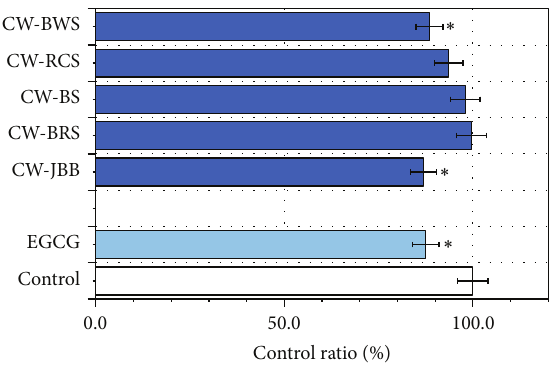
∗∗∗ Figure 7: Changes in the Thioflavin T fluorescence of BSA+D- Figure 8: Changes in the Thioflavin T fluorescence of LAB+D- ribose treated with plant sprouts’ aqueous extracts (PSAE). BSA ribose treated with plant sprouts’ aqueous extracts (PSAE). LAB (final concentration 10mg/mL) in the presence of D-ribose (final (final concentration 10mg/mL) in the presence of D-ribose (final concentration 1M) was kept at 37 ∘ C in Tris-HCl buffer (pH 7.4). concentration 1M) was kept at 37 ∘ C in Tris-HCl buffer (pH 7.4). Thioflavin T (final concentration 30 𝜇 M) was mixed with samples of Thioflavin T (final concentration 30 𝜇 M) was mixed with samples of BSA+D-ribose+PSAE, as described in Section 2.7. The fluorescence LAB+D-ribose+PSAE, as described in Section 2.7. The fluorescence intensity of Thioflavin T was recorded ( 𝜆 ex 430 nm; 𝜆 em 465 nm). intensity of Thioflavin T was recorded ( 𝜆 ex 430 nm; 𝜆 em 465 nm). BSA and D-ribose were used as a control. Aliquots were taken for LAB and D-ribose were used as a control. Aliquots were taken for measurements of fluorescence spectra ( 𝜆 ex = 430nm). Values are measurements of fluorescence spectra ( 𝜆 ex = 430 nm). Values are mean ± SD of the three measurements. ∗ 𝑃 < 0.05 compared with mean ± SD of the three measurements. ∗ 𝑃 < 0.05 compared with the controls. the